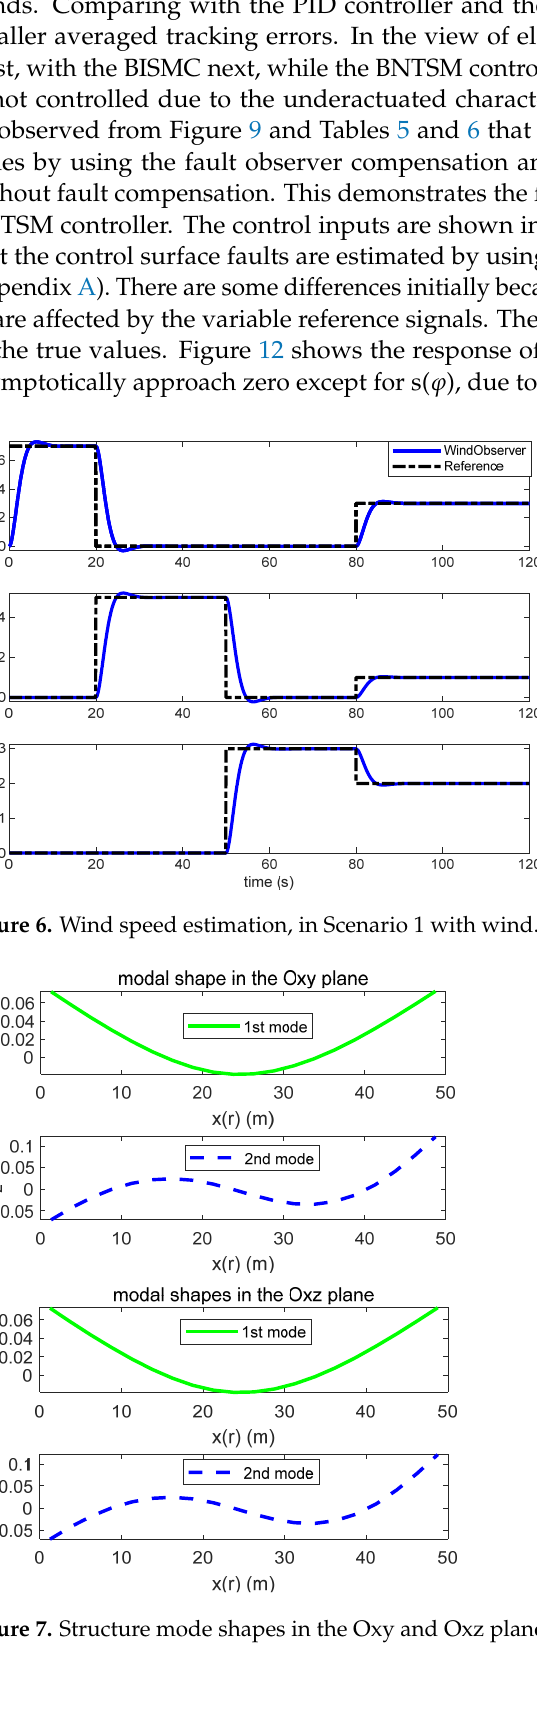
Figure 7. Structure mode shapes in the Oxy and Oxz planes.